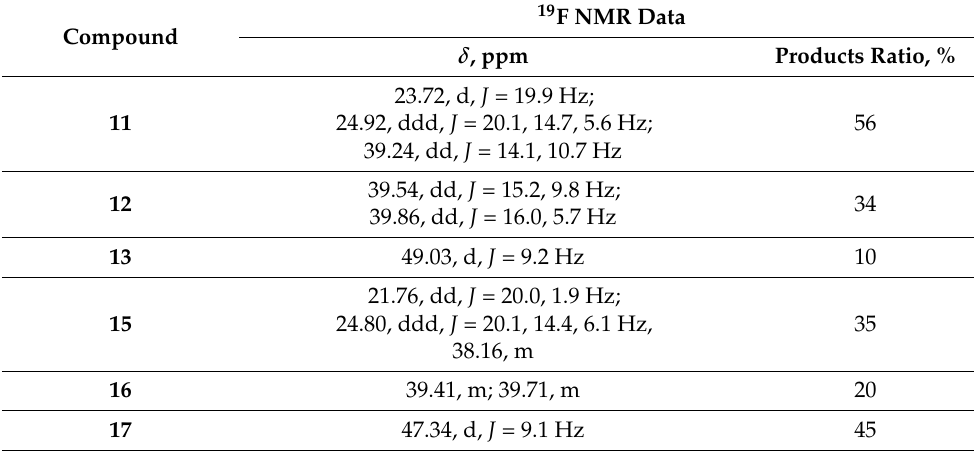
Table 3. 19 F NMR data of mixtures of Cs 2 CO 3 -promoted reactions of flavone 2 with 1 H -1,2,4-triazole and imidazole.